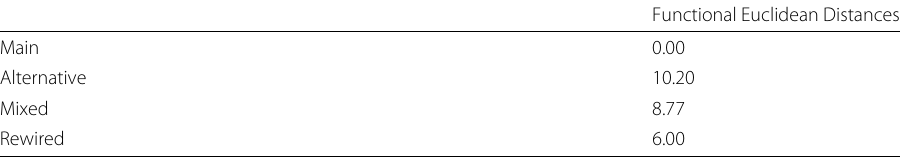
Functional Euclidean Distances